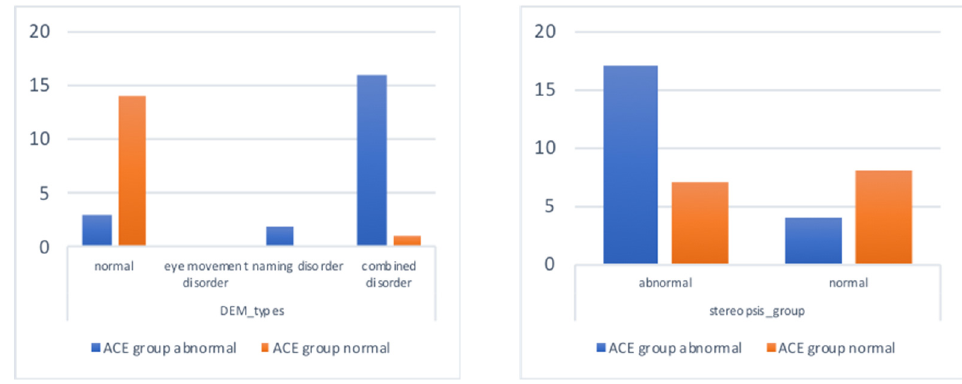
Figure 2. DEM and stereopsis performance between ACE-normal and -abnormal subjects.